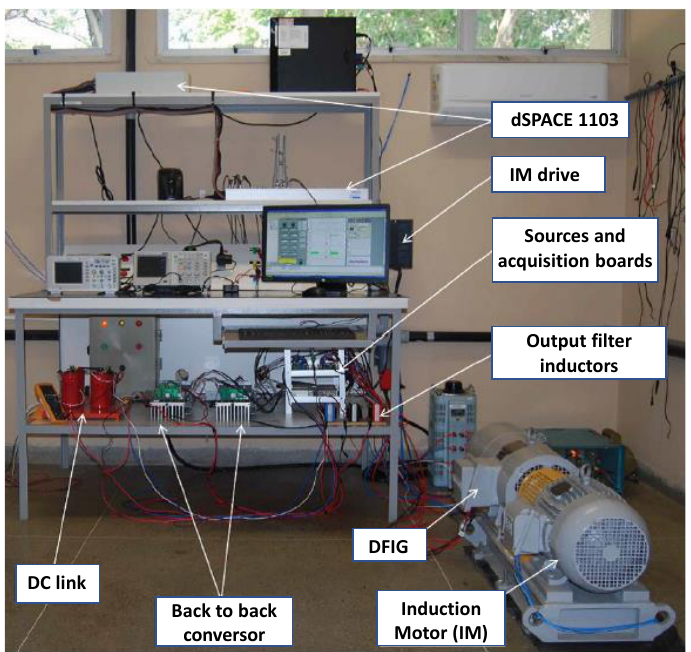
Figure 2. Equipments used in the experimental tests. DFIG: doubly-fed induction